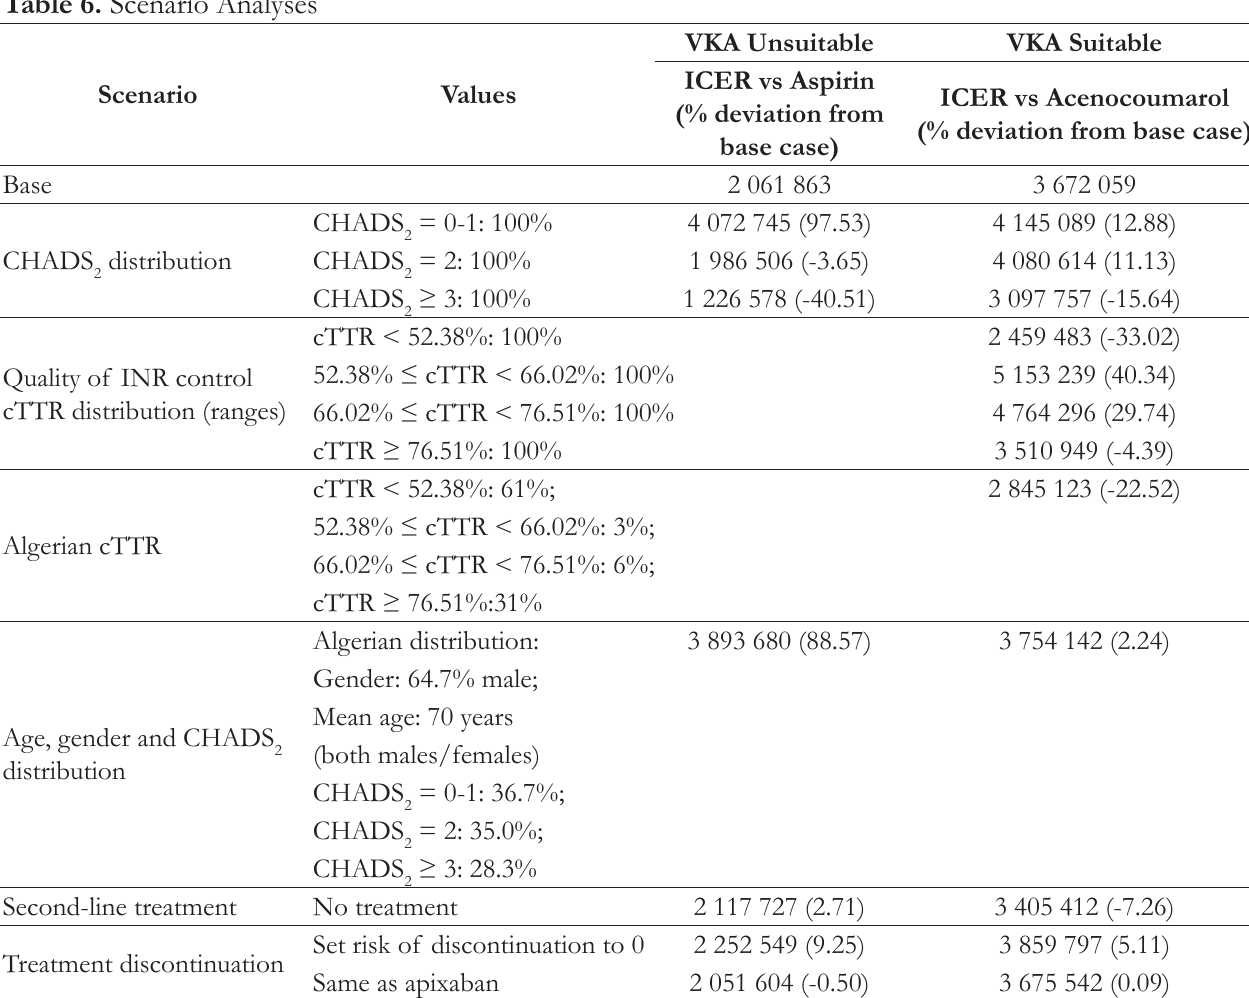
Table 6. Scenario